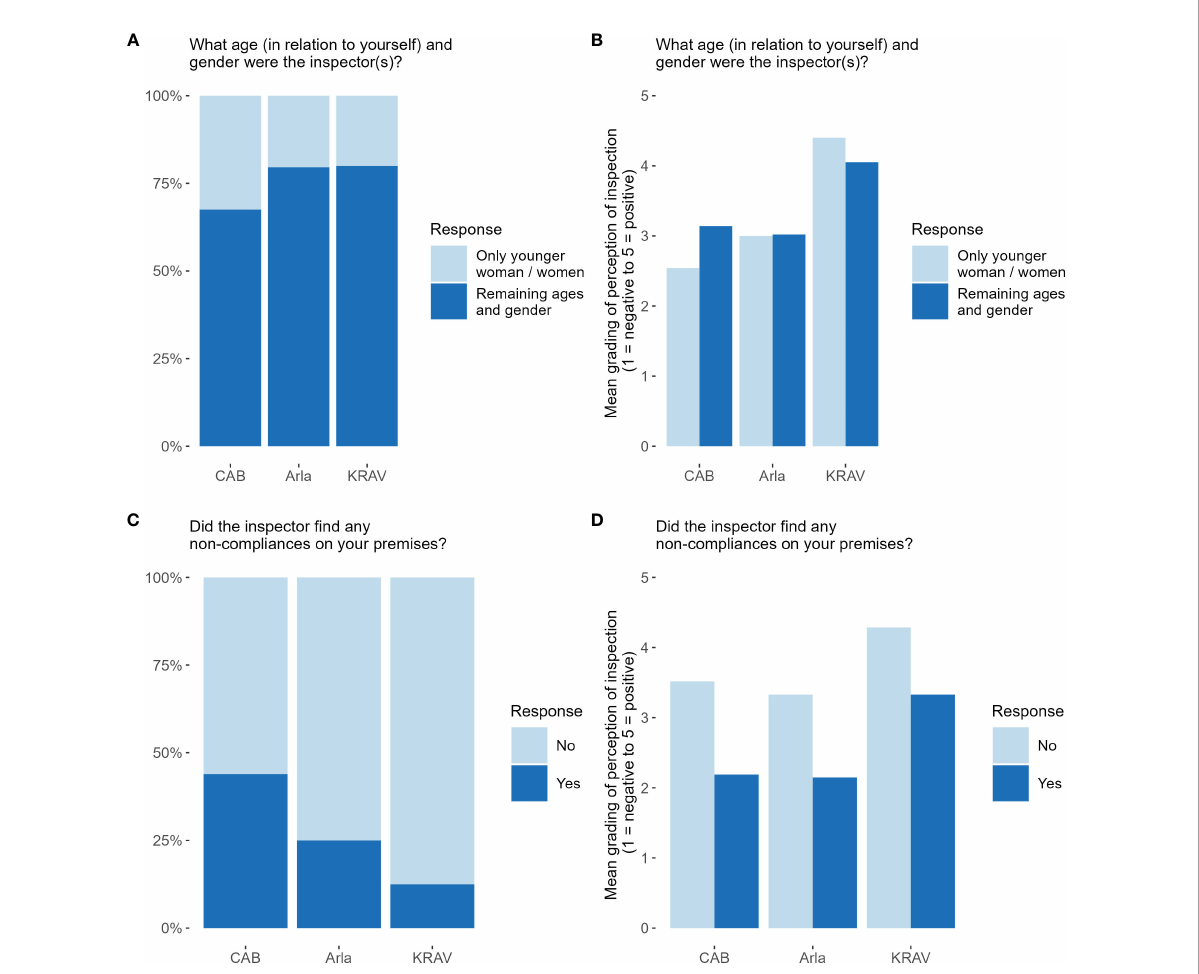
FIGURE 4 Response distributions (A, C) for two of the categorical questions and for each of the different inspections CAB (n = 107-114), Arla (n = 52-54) and KRAV (n = 24-25). (B, D) show the mean value of the perception of each inspection (graded from 1 = negative to 5 = positive) depending on the response to the